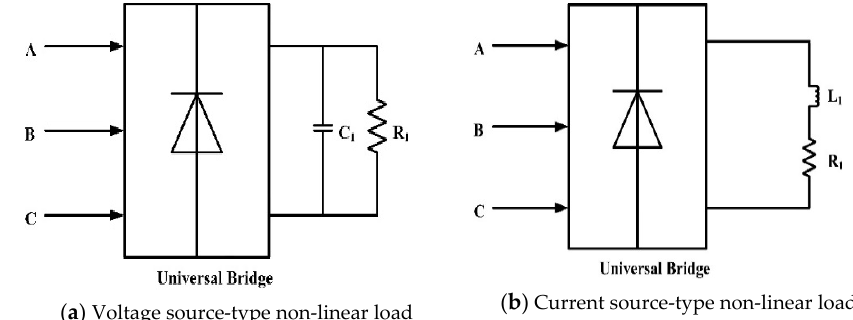
Figure 13. Circuit diagrams of three phase non-linear loads.